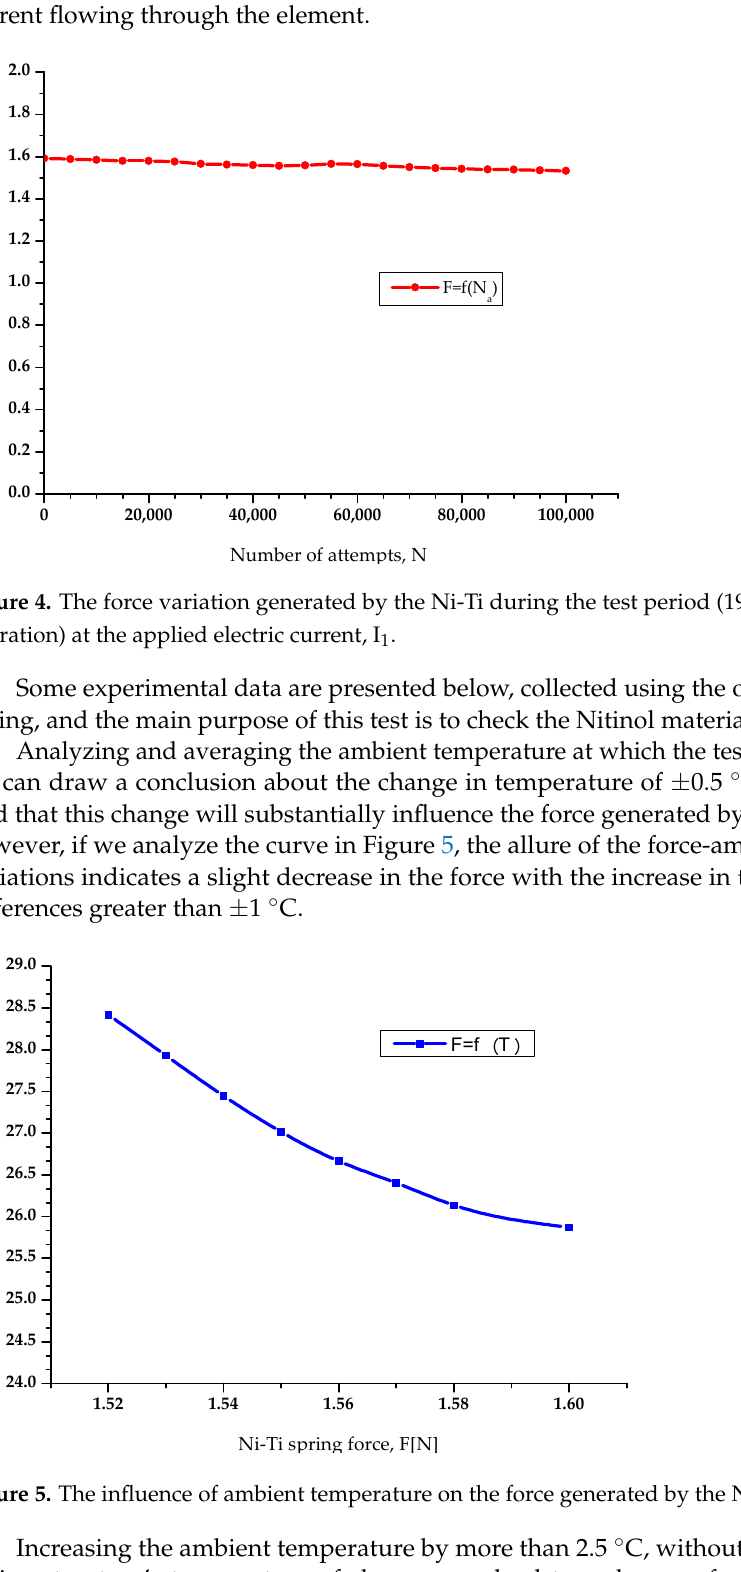
Figure 3. Temperature distribution on the nitinol spring recorded with a thermal imaging camera: ( a ) operating period; ( b ) rest period.